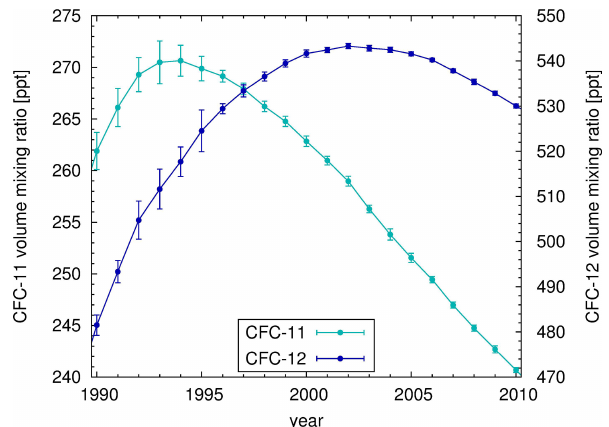
Figure 1. Annual global means of CFC-11 and CFC-12 volume mixing ratios at the surface calculated from monthly data of the NOAA/ESRL halocarbons program. Error bars indicate the mean standard deviations of the monthly